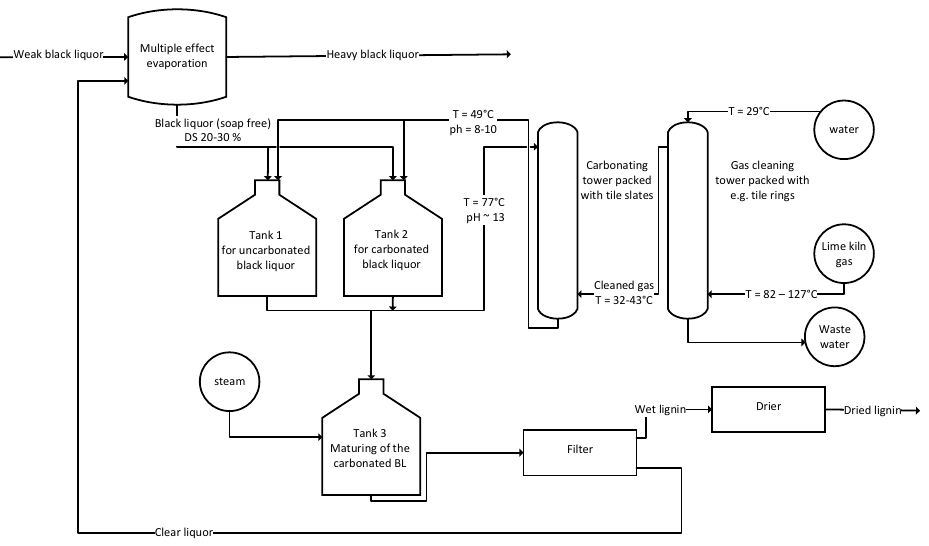
Figure 2. Schematic drawing of the WestVaco process. Black liquor is extracted from the evaporation train with a solids content of 20–30 wt%. Tank 1 and 2 are operated alternatingly, either being used as tanks for the un-carbonated or for the already carbonated black liquor. A tank is needed for the acidification, which is performed with plant derived CO 2 and more than one passing of the carbonating column is needed to obtain a pH of 9. The carbonating column is set up as packed column. To increase the filterability of the precipitated lignin, maturing is performed in tank 3 and the temperature of the carbonated liquor is increased to 71–93 ◦ C. The preferred temperature mainly depends on the source of black liquor and the rate of heating. After heating, the black liquor is allowed to cool down to improve the filterability once again. The treated black liquor is then filtered and either dried or further processed [27].